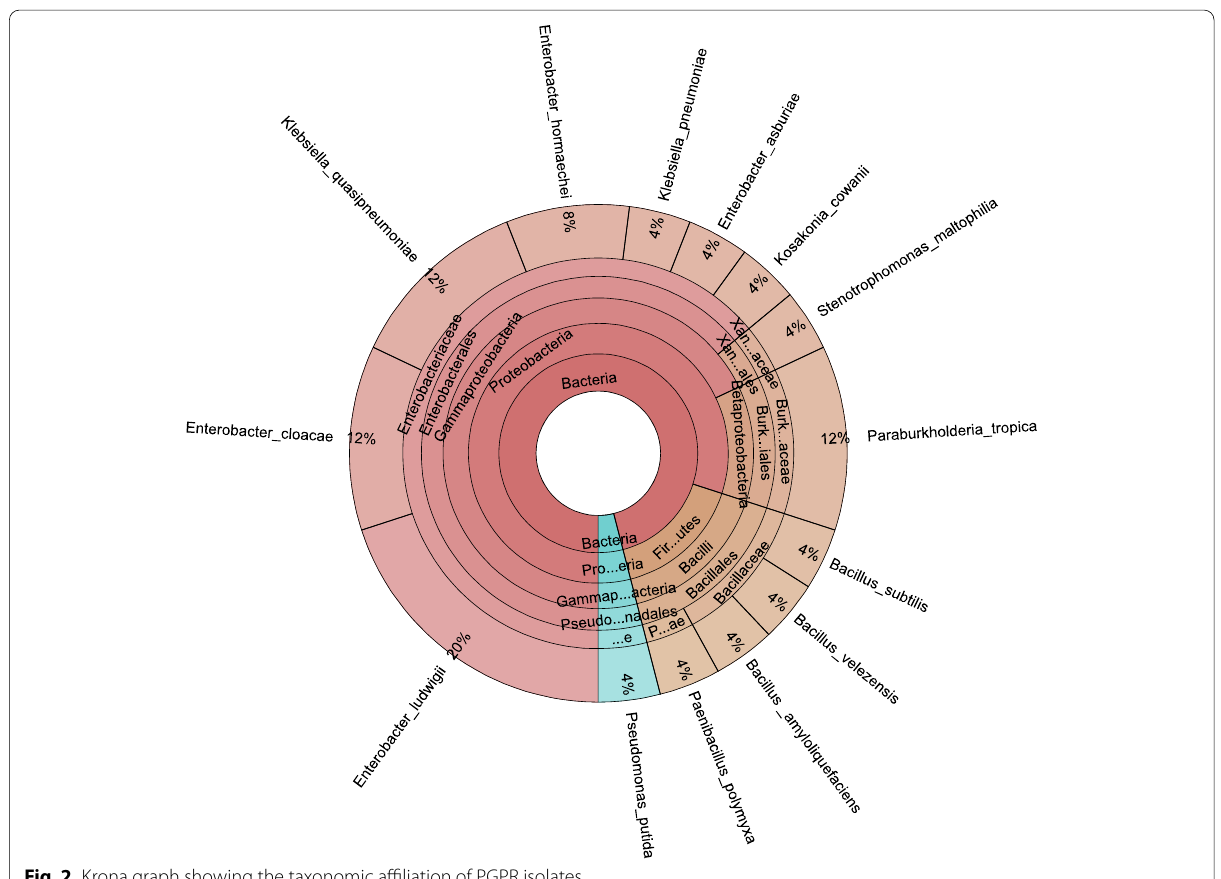
Fig. 2 Krona graph showing the taxonomic affiliation of PGPR